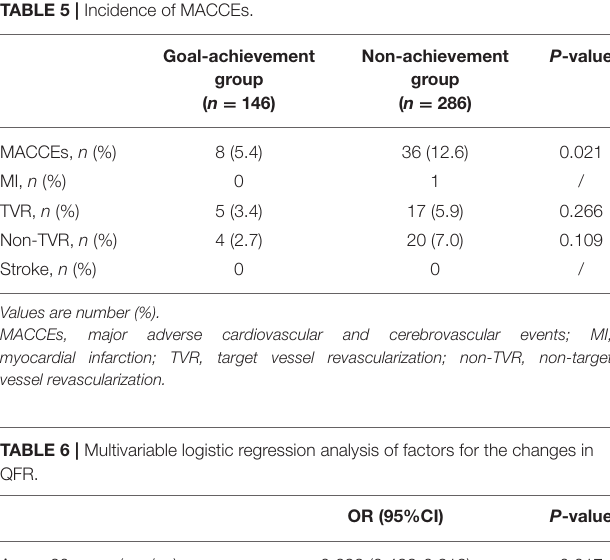
TABLE 5 | Incidence of MACCEs.